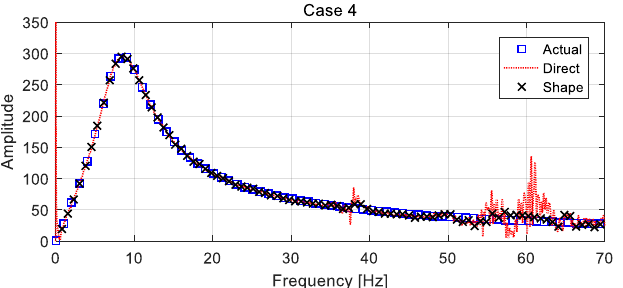
Figure 15. Comparison of the amplitudes of the vehicle acceleration FRF along DOF u 1 in Case 4.